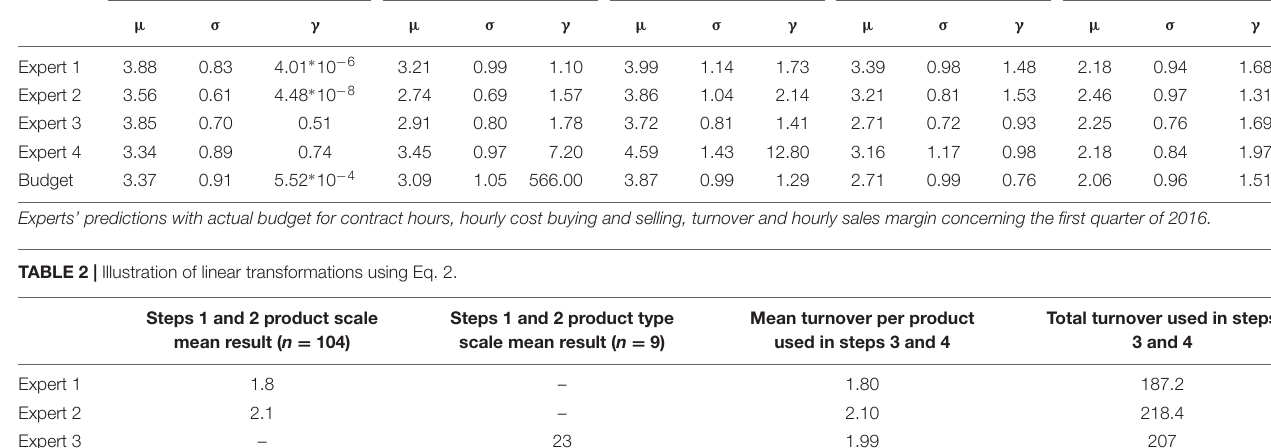
TABLE 1 | Results for elicitation with the staffing company. Contract hours Hourly cost buying